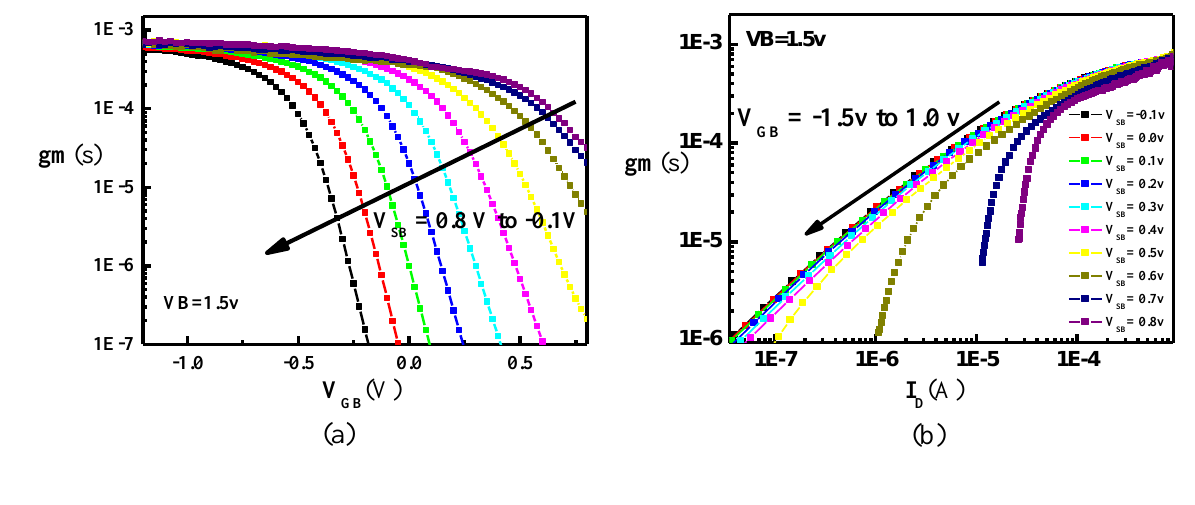
-V (b) g -I of the ISFET for various V m GB m D